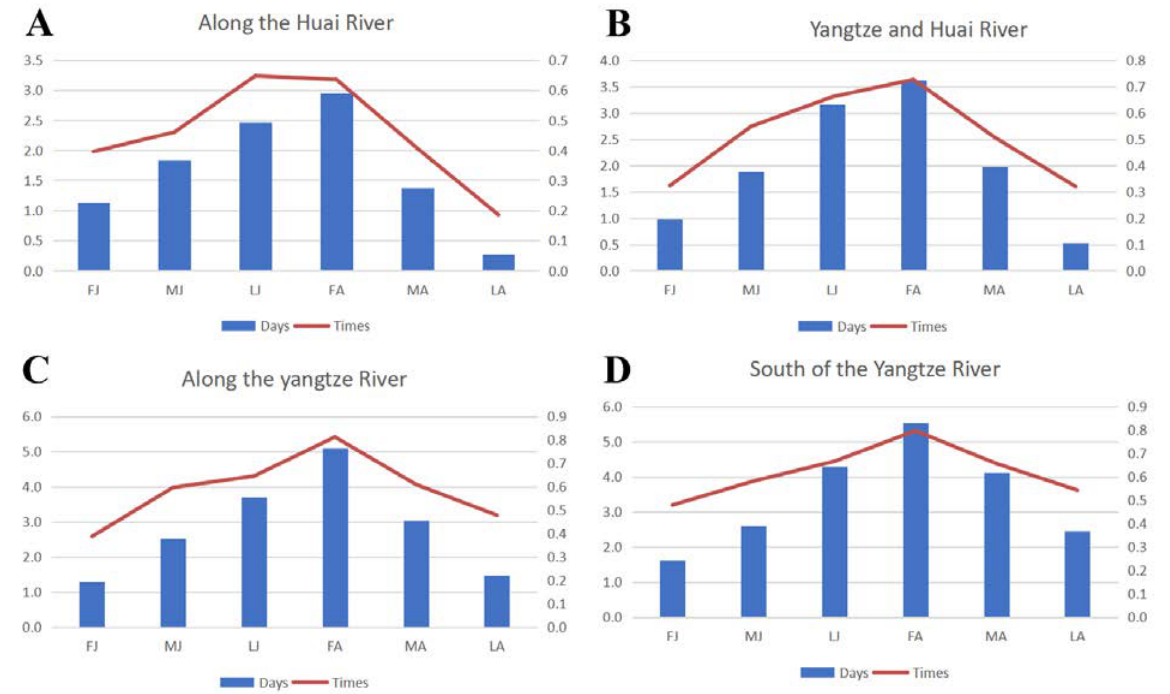
Figure 1. Timing and frequency of high-temperature damage in different subareas of rice at the flowering and panicle stages. ( A ) The area along the Huai River (Yanhuai, YH); ( B ) the area in Yangtze and the Huai River (Jianghuai, JH); ( C ) the area along the Yangtze River (Yanjiang, YJ); ( D ) the area south of the Yangtze River (Jiangnan, JN).